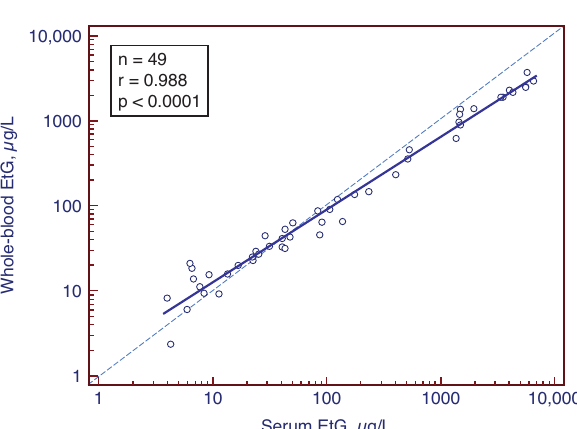
Figure 2: The correlation between EtG in whole blood and serum presented in logarithmic